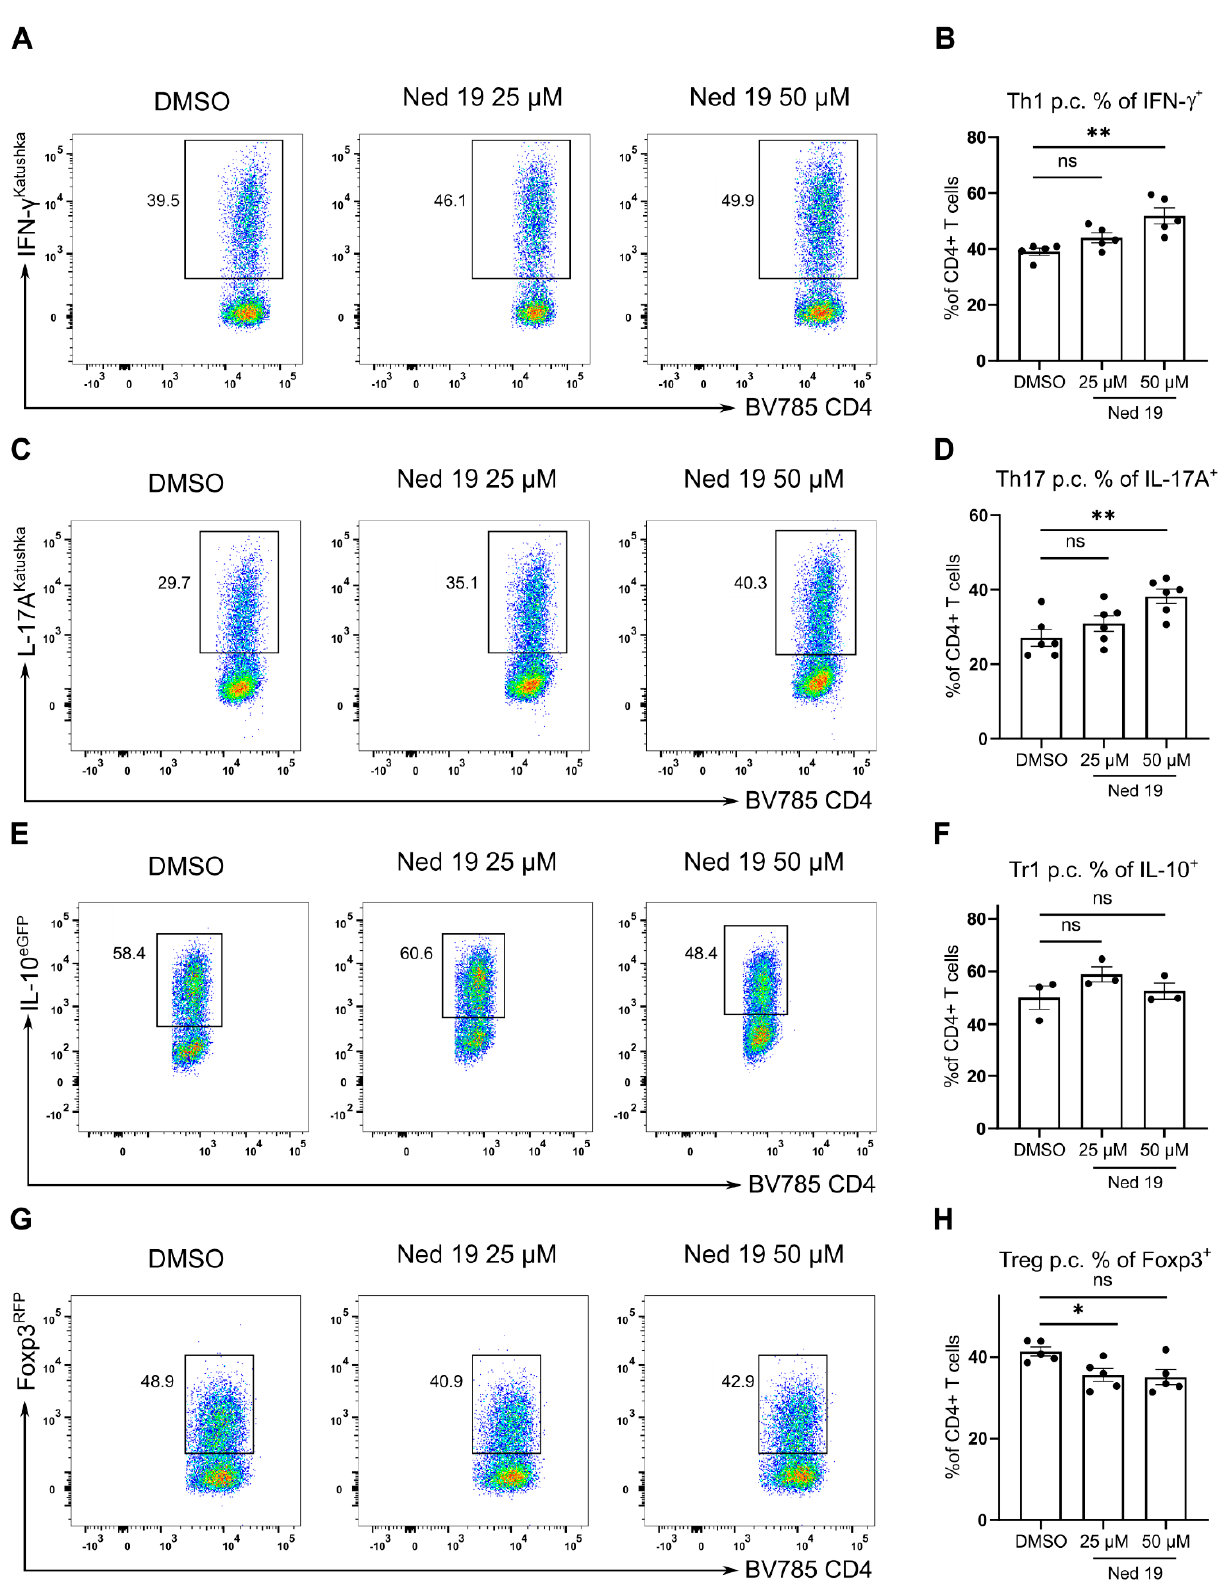
Figure 4. Trans-Ned 19 promotes the differentiation of Th1 and Th17 cells without a significant impact on the differentiation of regulatory T cells in vitro. Total CD4 + T cells were freshly isolated from IL-17A Katushka × IL-10 eGFP × Foxp3 RFP mice for Tr1 in vitro differentiation and naïve CD4 + T cells from IL-17A eGFP × IFN- γ Katushka × Foxp3 RFP for Th1, Th17 and Treg cells. Cells were incubated with increasing concentrations of trans-Ned 19 for 1 h and stimulated with plate bound anti-CD3